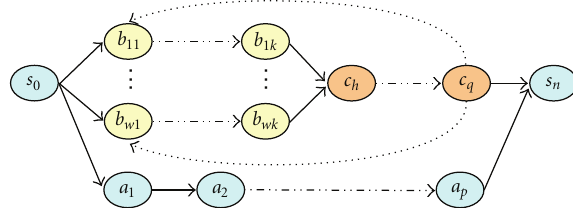
Figure 9: Structure of the regular expressions from the benchmark